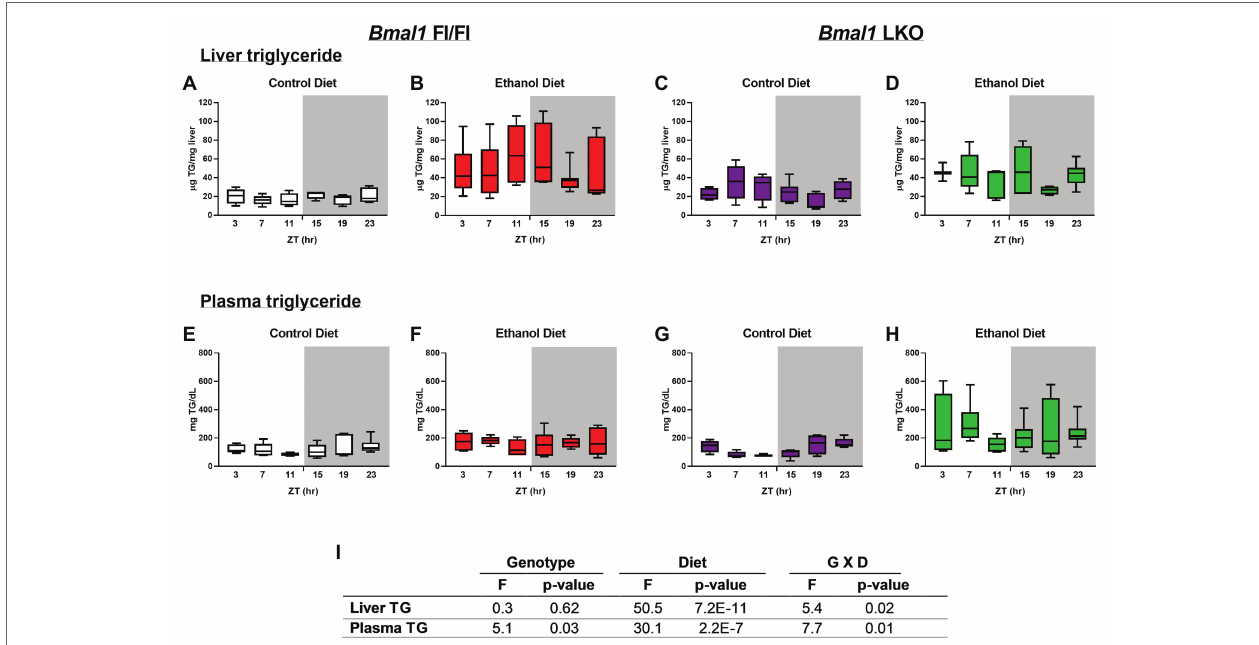
FIGURE 2 | Chronic alcohol and liver clock disruption alter diurnal variations in liver and plasma triglyceride levels. Liver (A–D) and plasma (E–F) triglyceride (TG) were measured in samples collected from control-fed ( A,E white) and alcohol-fed ( B,F red) Bmal1 Flox/Flox (Fl/Fl) and control-fed ( C,G purple) and alcohol-fed ( D,H green) Bmal1 liver-specific knockout (LKO) mice at ZT 3, 7, 11, 15, 19, and 23 (ZT 0: lights on/inactive period, ZT 12: lights off/active period, gray area). Data are shown as min to max box and whisker plots for n = 3–8 mice/genotype/diet/time-point. Results from two-factor ANOVA are provided in (I)